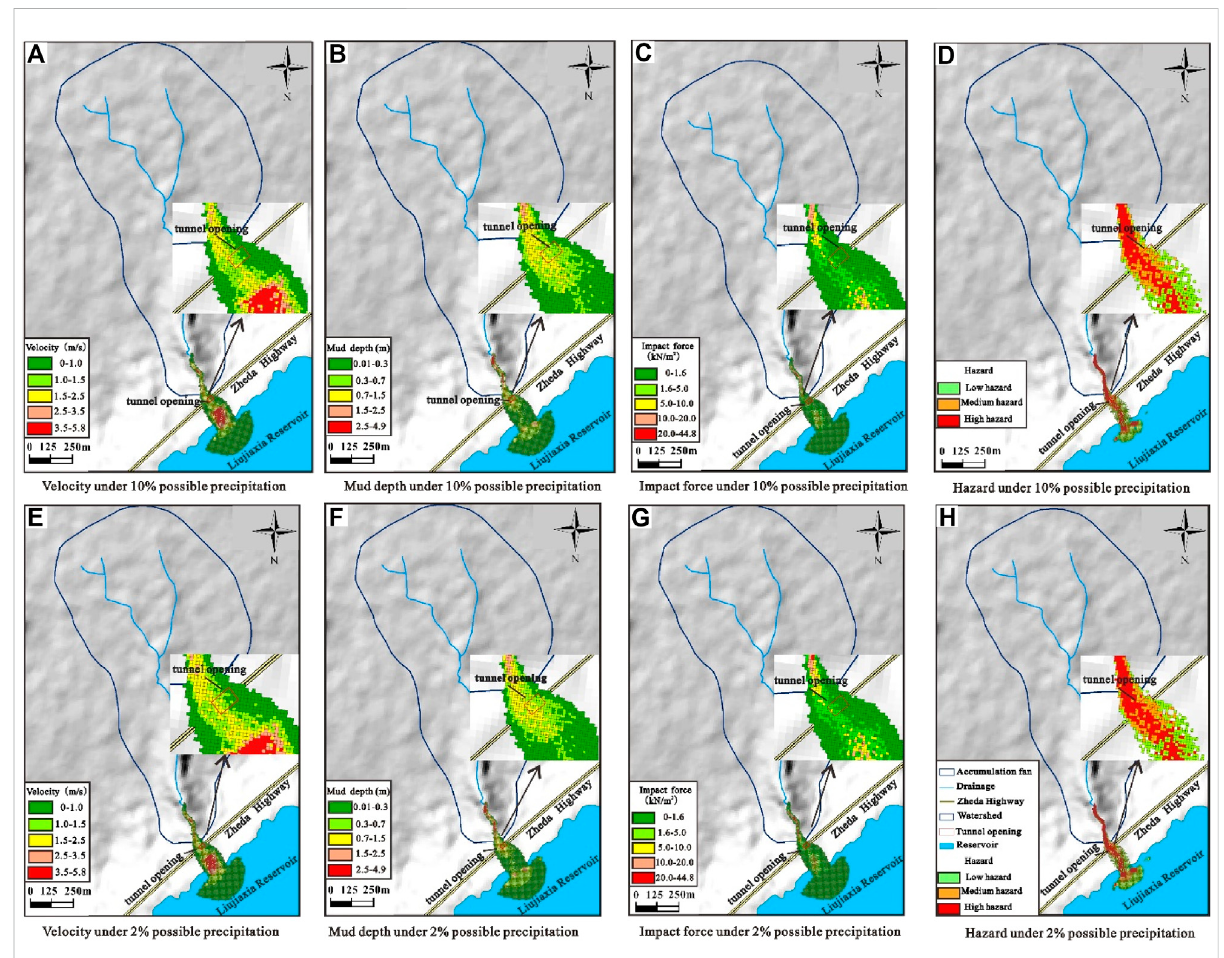
FIGURE 6 Simulation results of debris fl ow movement characteristics and danger ranges based on FLO-2D under two precipitation conditions.